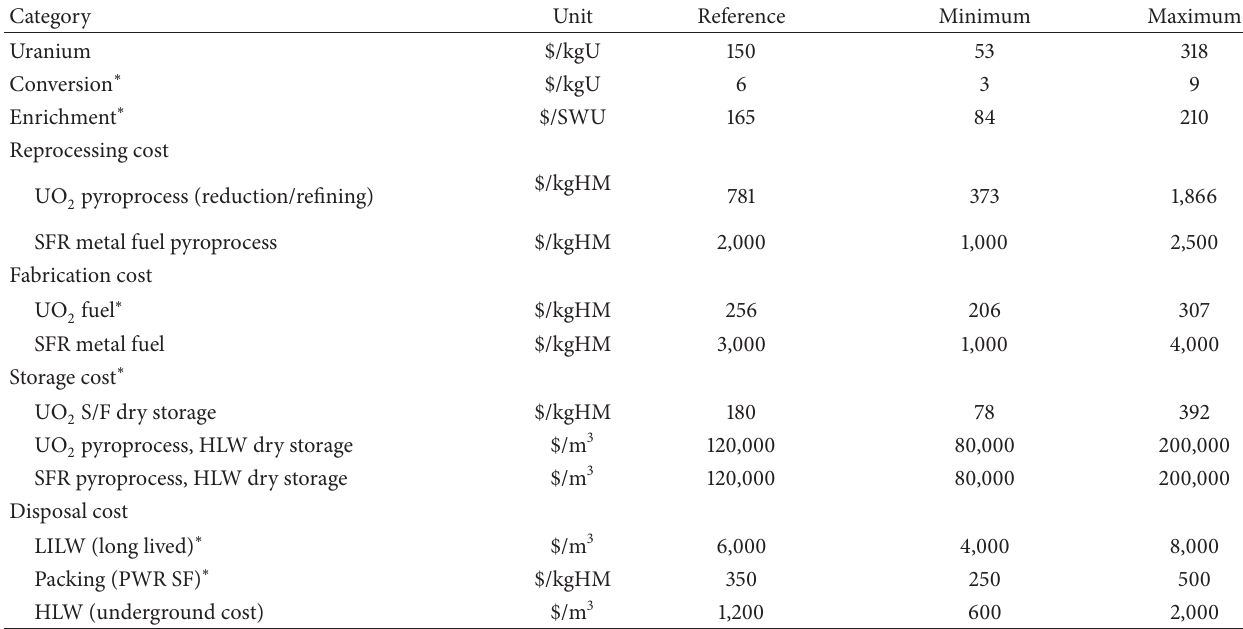
Table 6: Input data for economic assessment of SFR fuel.